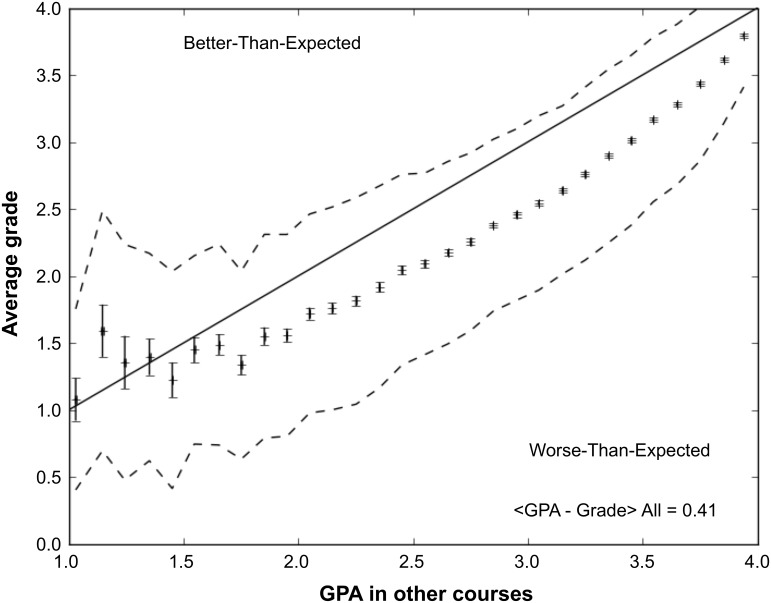
The relation between physics grade and GPAother for students taking Physics 140.The points show mean grades for students in each bin of GPAother; error bars show the error on these means. The dashed lines show the one sigma dispersion in the relation between grade and GPAother. The grade penalty for this course is defined as the quantity GPAother—grade averaged over all students. For Physics 140, this grade penalty is 0.41 on a 4.0 scale.